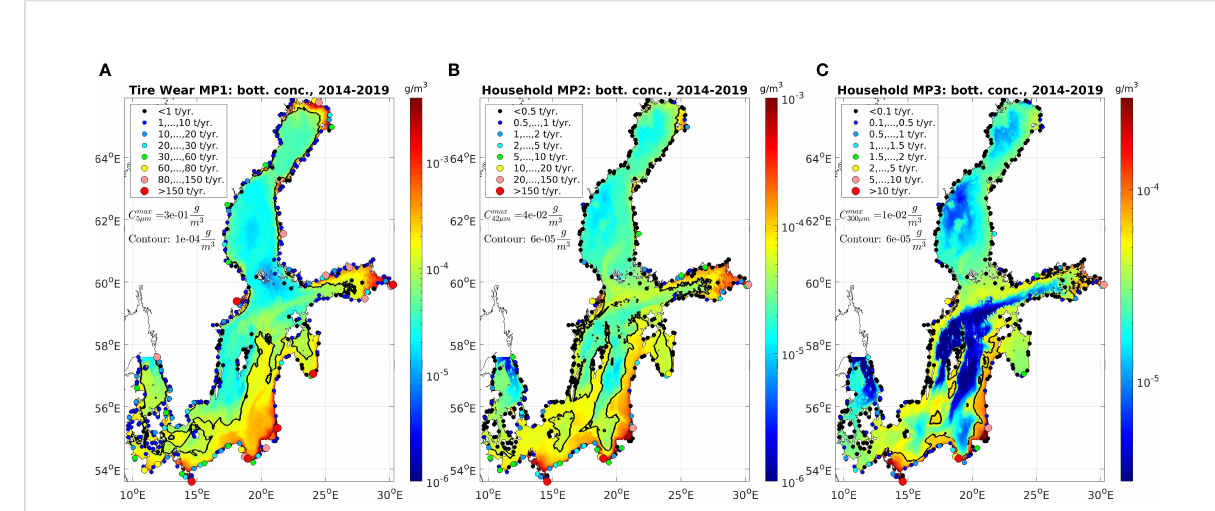
FIGURE 7 Near the seabed pattern of microplastics from tire wear microplastics MP1 (A) and household microplastics MP2 (B) and MP3 (C) , 6 years mean 2014 – 2019. Contours show the average MP1 concentrations of 10 -4 g/m 3 and MP2 and MP3 concentrations of 6·10 -5 g/m 3